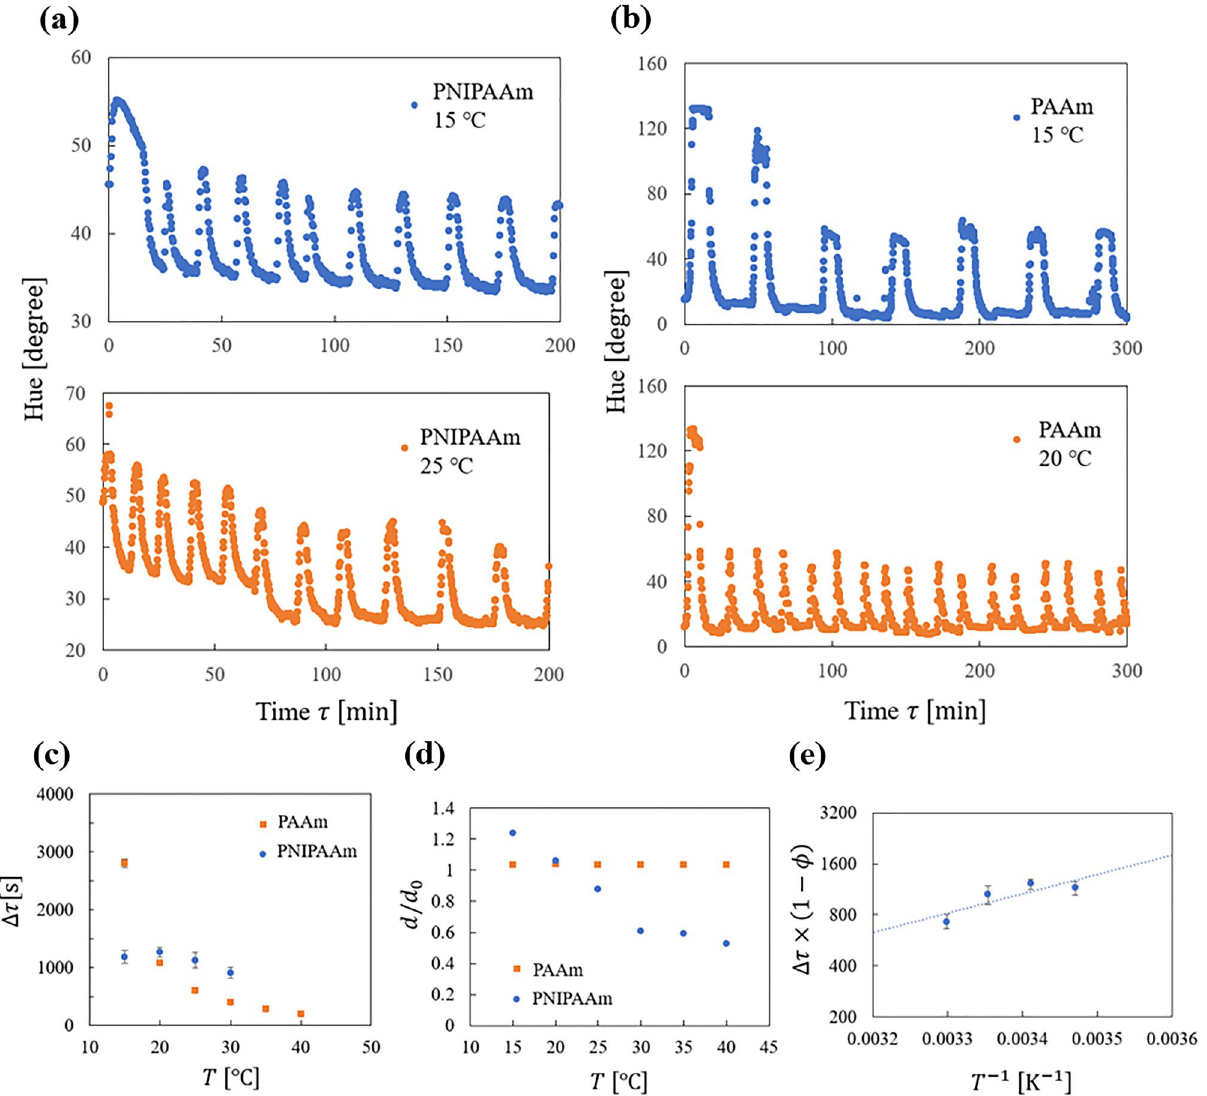
Figure 4. ( a ) Typical time evolution of hue for BZ gels obtained for PNIPAAm, 15 °C, 25 °C. ( b ) That for PAAm, 15 °C, 20 °C. ( c ) Temperature dependence of the period. Orange square and blue circle show the case for PAAm and PNIPAAm, respectively. Error bars are the standard error over the average of 5 samples for PAAm 15 °C and 10 samples for the others. (Error bars are omitted when point size is larger than that.) ( d ) Temperature dependence othe BZ gel diameter. The vertical value is divided by the diameter when the gel is synthesized. Orange square and blue circle show the case for PAAm and PNIPAAm, respectively. ( e ) Inverse temperature vs. period times ( 1 − φ) . Points show experimental data, and the dashed line shows the fitting curve using Eq. (19). Error bars are the same as that of in ( d